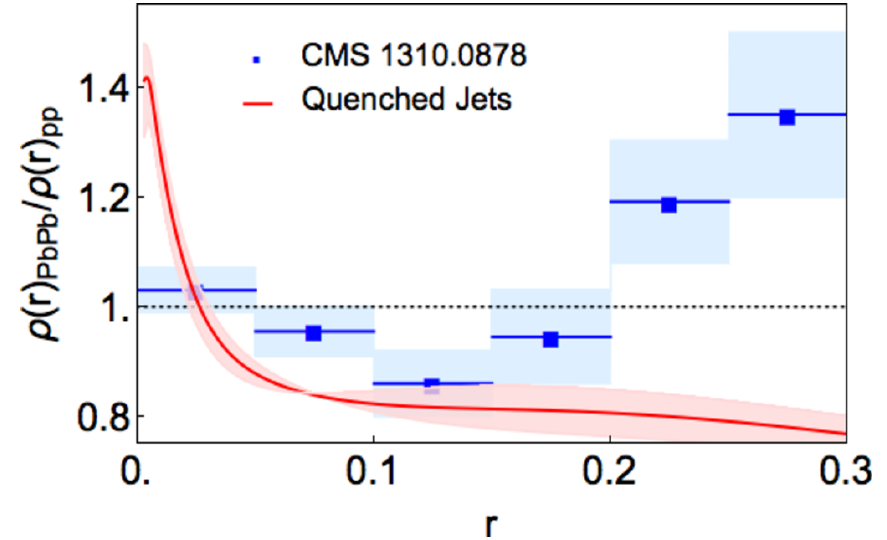
Figure 10 . The ratio of the mean shape of the jets in our ensemble after they have been quenched by their passage through the expanding cooling droplet of plasma, as described in section 3, to their mean shape before quenching, shown in (cid:12)gure 8. As in (cid:12)gures 8 and 9, the pink band shows our results for a = 1 : 8 (cid:0) 2 : 5 with a = 2 shown in dark red. The CMS measurement [33] of the modi(cid:12)cation of the mean jet shape, namely the ratio of its measured value for jets with energy above p 100 GeV reconstructed with anti- k t R = 0 : 3 in 0-10% central PbPb collisions with s NN =2.76 TeV to that in proton-proton collisions, as in (cid:12)gure 8, is shown as the blue symbols. The discrepancy between our calculation and the experimental measurements at large angles r relative to the center of the jet is expected, since we do not include any analogue of the particles originating from the wake that the jet leaves behind in the plasma, some of which must necessarily be reconstructed as a part of the jet in any experimental analysis even after background subtraction